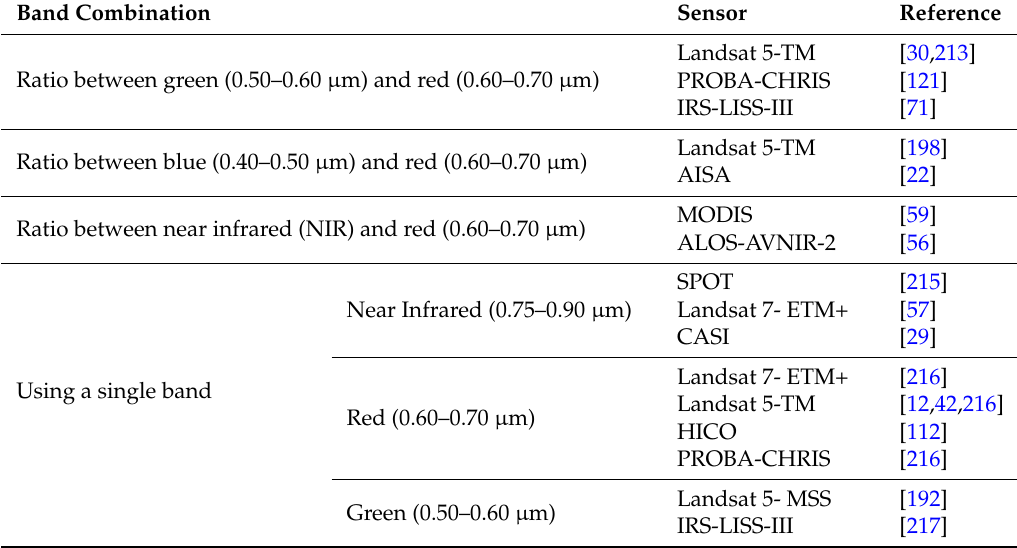
Table 8. Remotely measurements of Turbidity and Total Suspended Sediments using various spectral bands and their